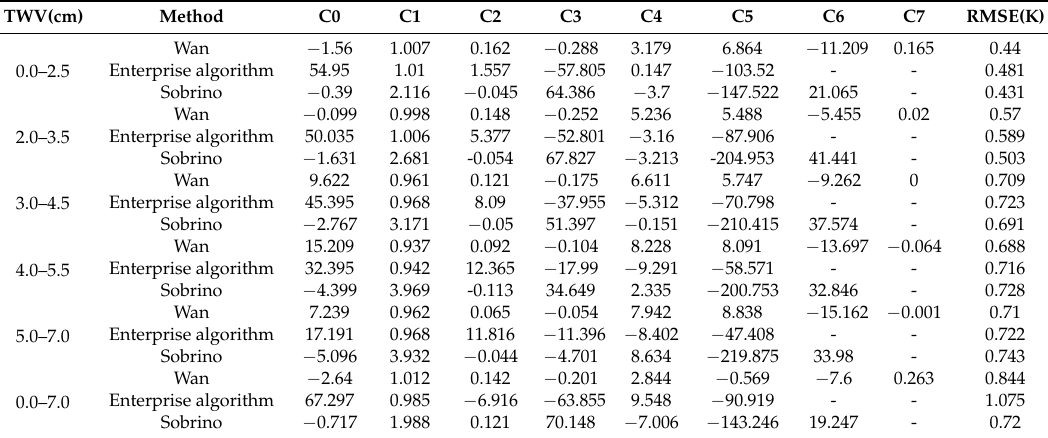
Table 2. Coefficients and uncertainty of the Enterprise algorithm, Wan, and Sobrino under different water vapor content